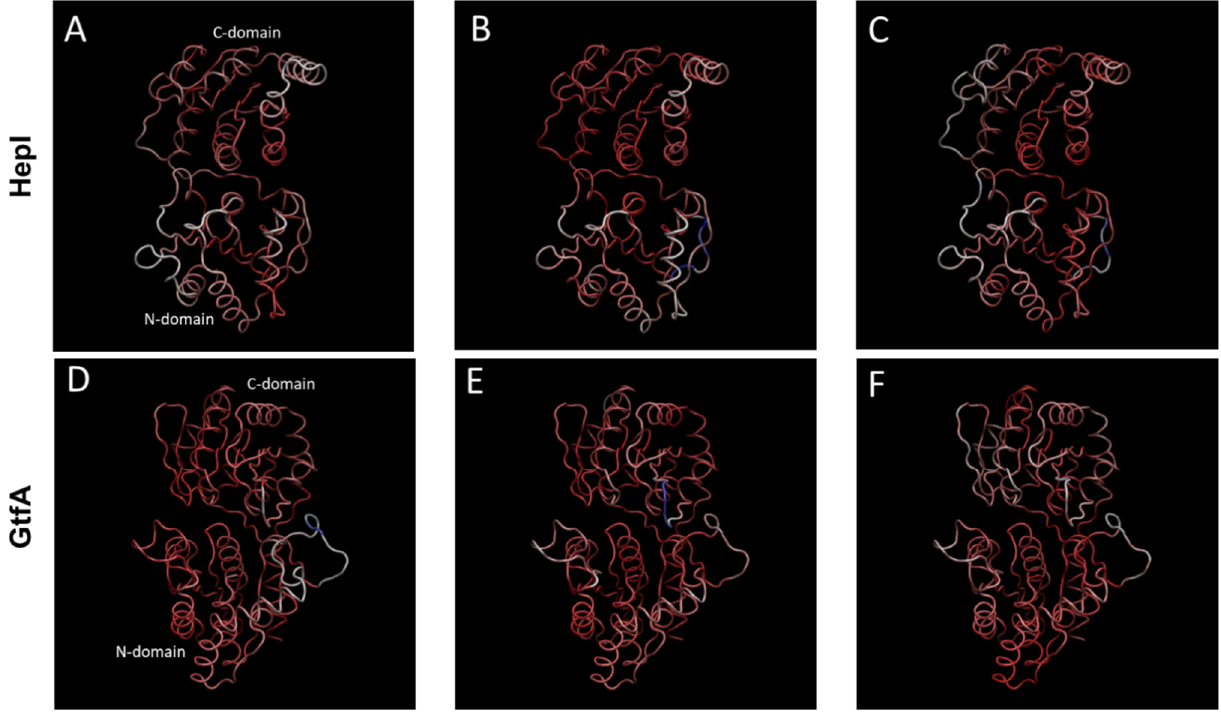
Figure 3. The first three principal components of quasiharmonic motions sampled by the 1.2 µs molecular dynamics trajectories for HepI ( A – C ) and for GtfA ( D – F ) (see Supplementary Figure S5 for animation). HepI and GtfA domains, C-domain, N -domain, and linker region are represented by white, blue, and green ribbons, respectively. These three large amplitude components account for 60.1 and 50.5% of dynamic motions, respectively, for HepI (top) and GtfA (bottom).